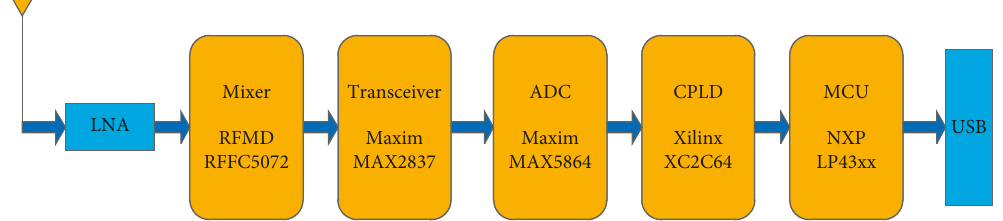
Figure 2: Hardware structure of HackRF One in the receiving